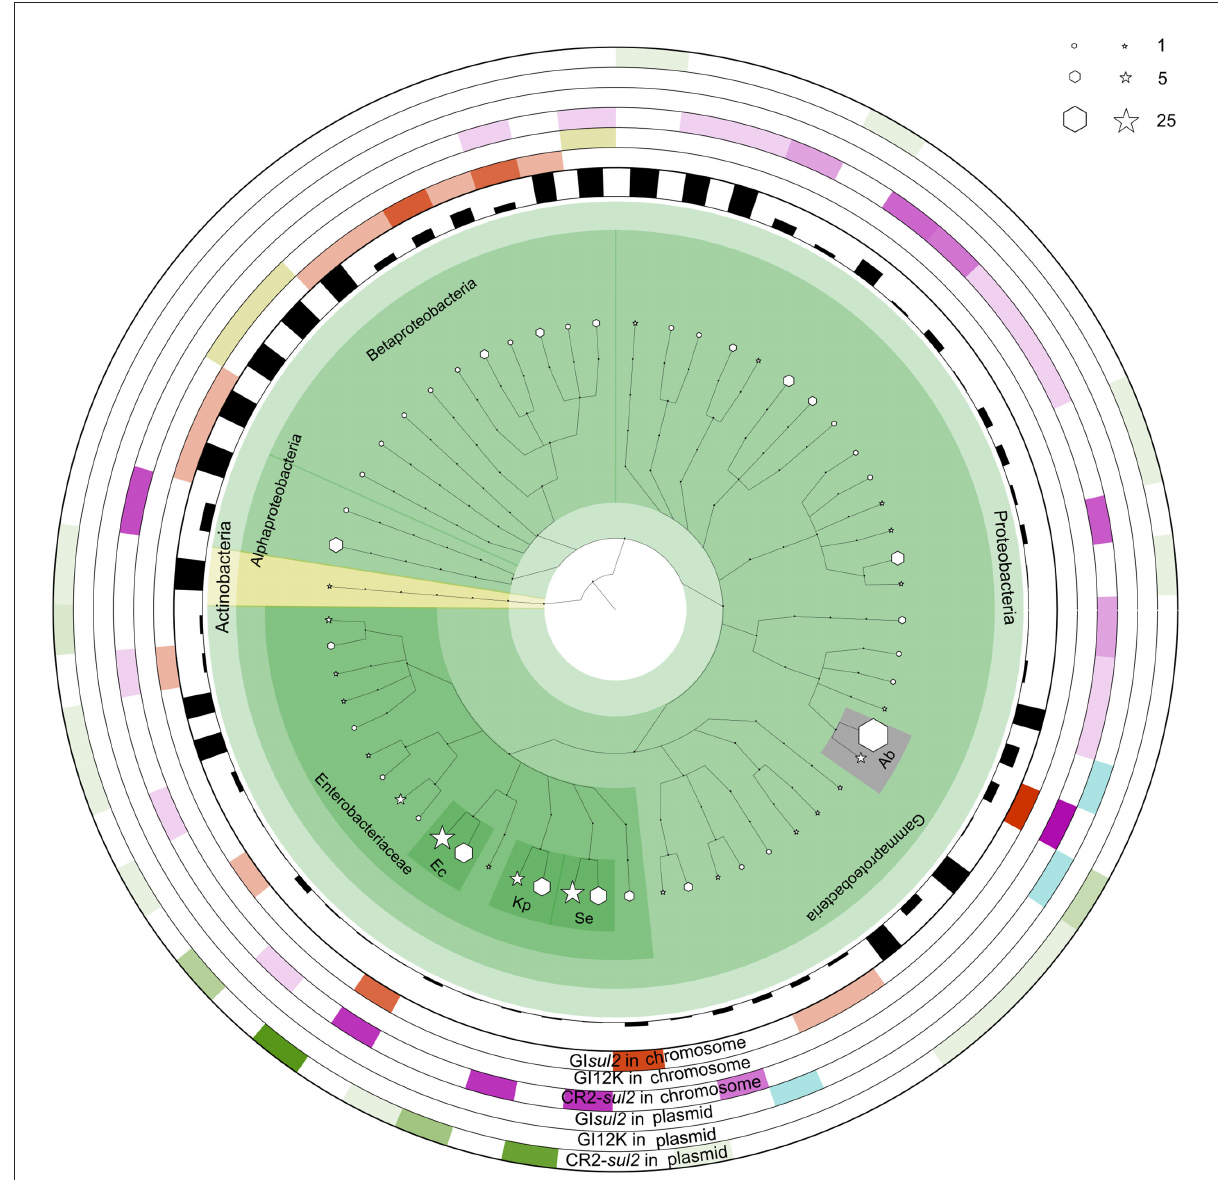
FIGURE6 The distribution of GI sul2 , CR2 -sul2 unit, and GI12K in chromosomes and plasmids of NCBI complete genome database. The internal species tree represent the host distribution of the three elements. The size of the hexagon and star markers denotes the number of genomes of each host carrying the corresponding elements in chromosomes or plasmids, respectively. The bar height in the inner circle represents the proportion of genomes carrying the elements among the total genome of the species in the database. The six outermost heatmaps represent each element’s abundance, separated by chromosomal or plasmid localization. The color intensity corresponds to the proportion of the host in the total number of genomes carrying the given element. Orange, olive green, and purple heatmaps represent the distribution of GI sul2 , GI12K, and the CR2 -sul2 unit in chromosomes, respectively. Blue and green heatmaps represent the dissemination of GI sul2 and CR2 -sul2 units in the plasmids, respectively. Hosts with a total number of genomes > 10 are highlighted and abbreviated as follows: Kp, Klebsiella pneumoniae ;